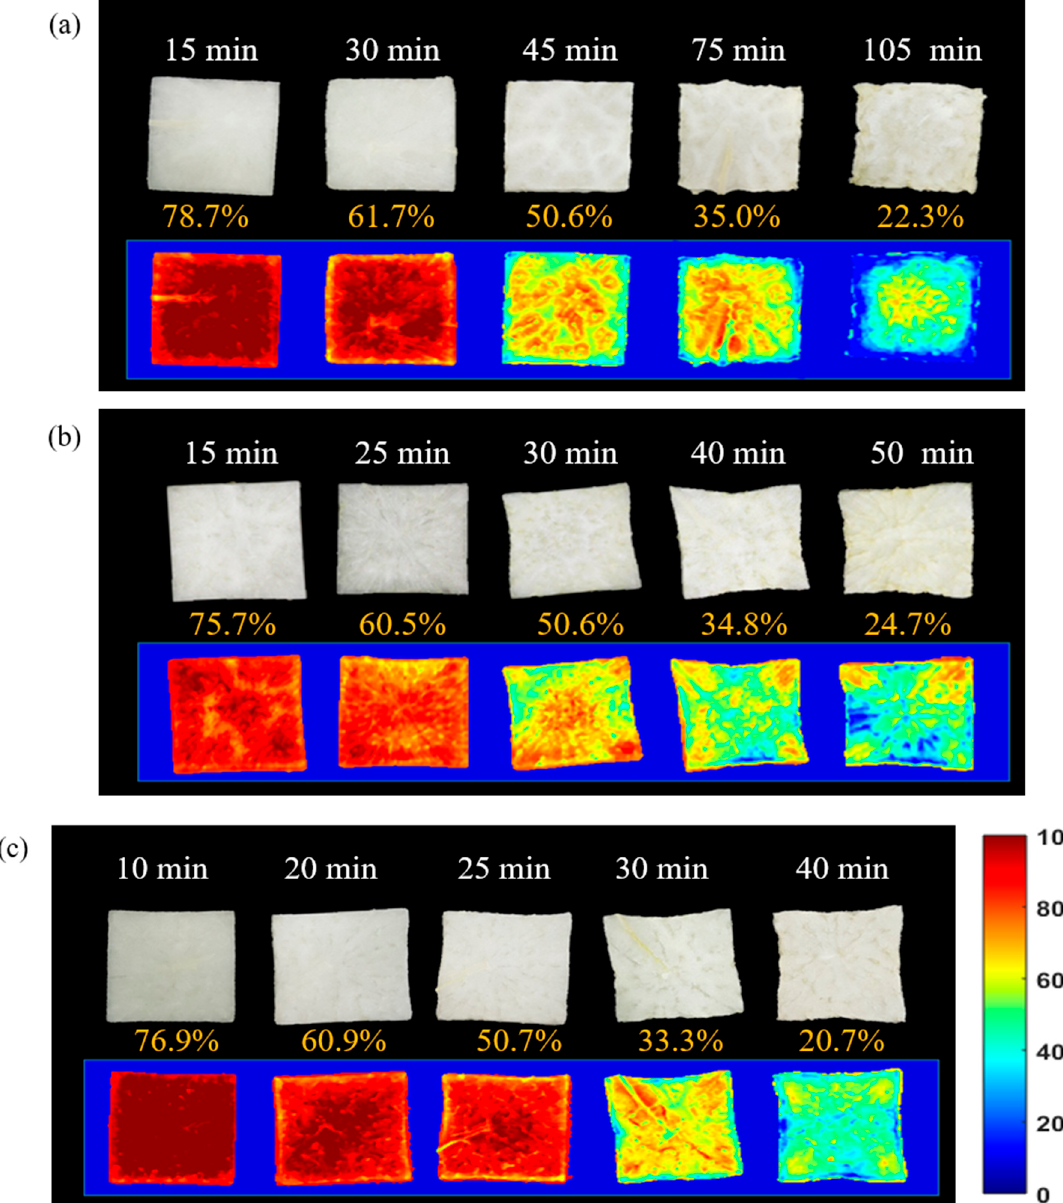
Figure 8. Moisture distribution map of radish slabs during different drying methods: ( a ) hot-air (HAD), ( b ) microwave (MD), ( c ) combination drying (HMCD).